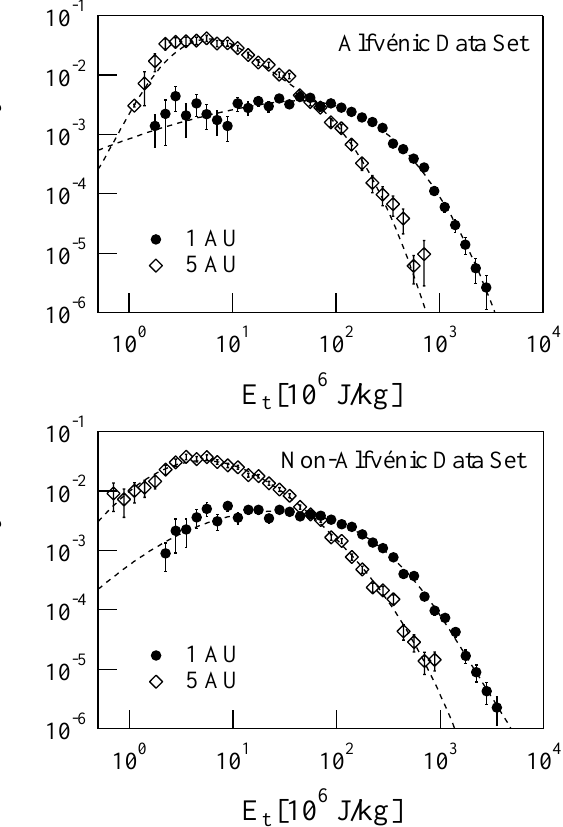
Fig. 5. The probability distribution functions P(E t ) of the total specific energy E t , relative to Alfv´enic fluctuations (upper panel) and non-Alfv´enic fluctuations (lower panel), for the two distances. Dashed lines are empirical model fits using Eq.